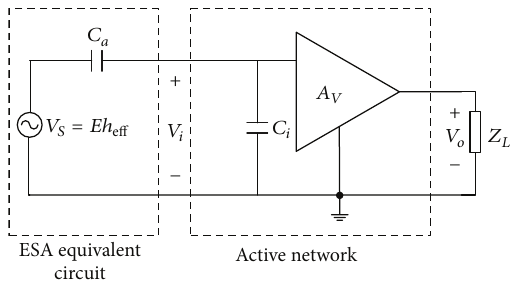
Figure 2: Equivalent circuit of a traditional active antenna.